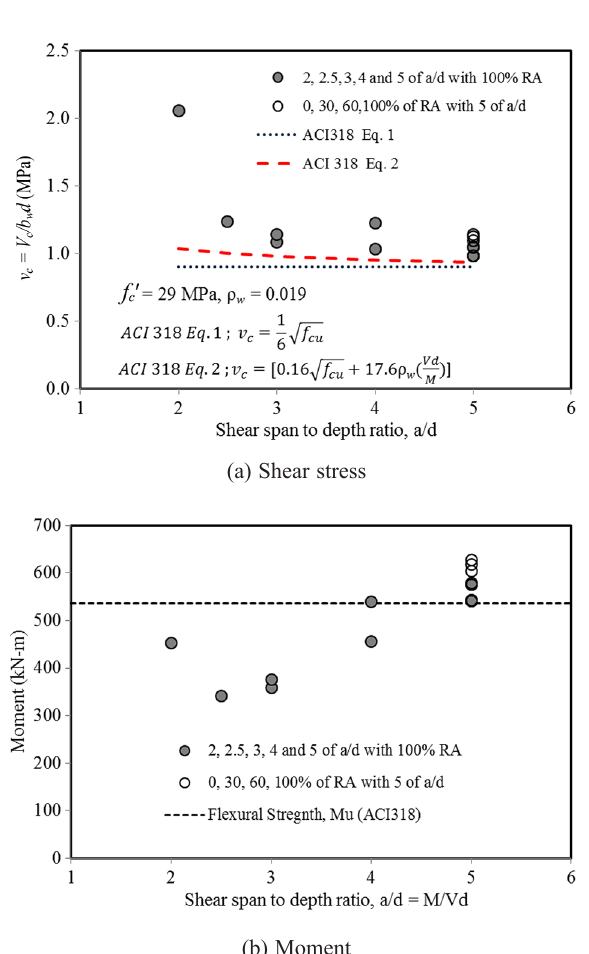
Fig. 8. Moments and shears at failure with respect to shear span-to-depth ratio